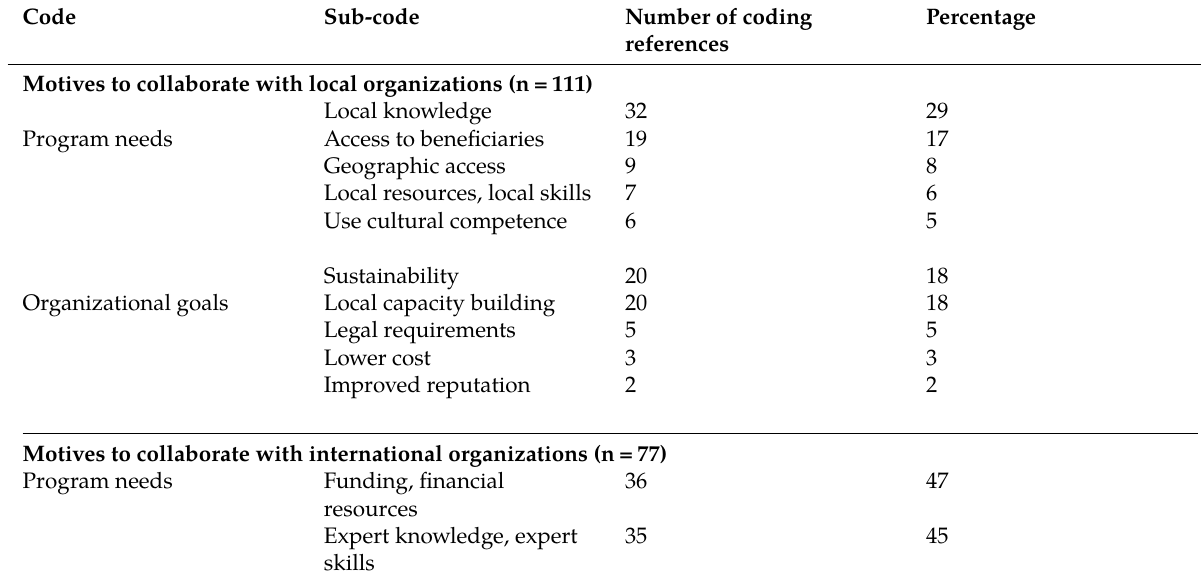
Table 2: Motives for